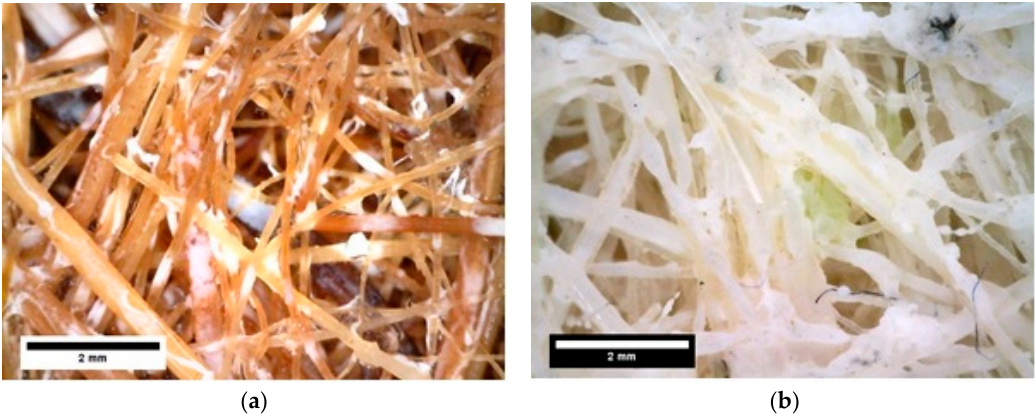
Figure 7. Microstructure of ( a ) dry Coir panel, ( b ) Fique panel.